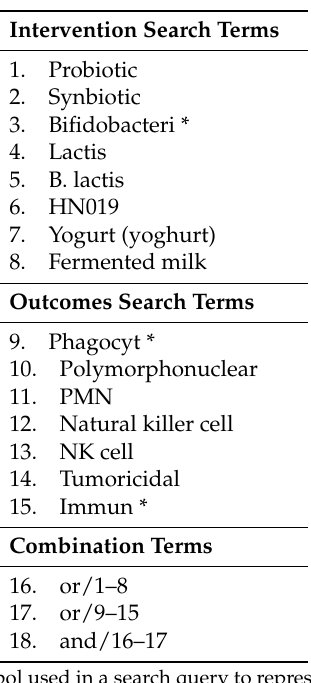
Table 1. Medline search